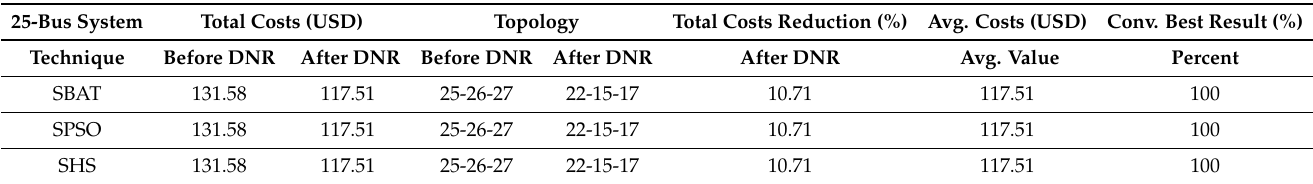
Table 14. Results found for the 25-bus and 27-branch balanced system (variable demand).